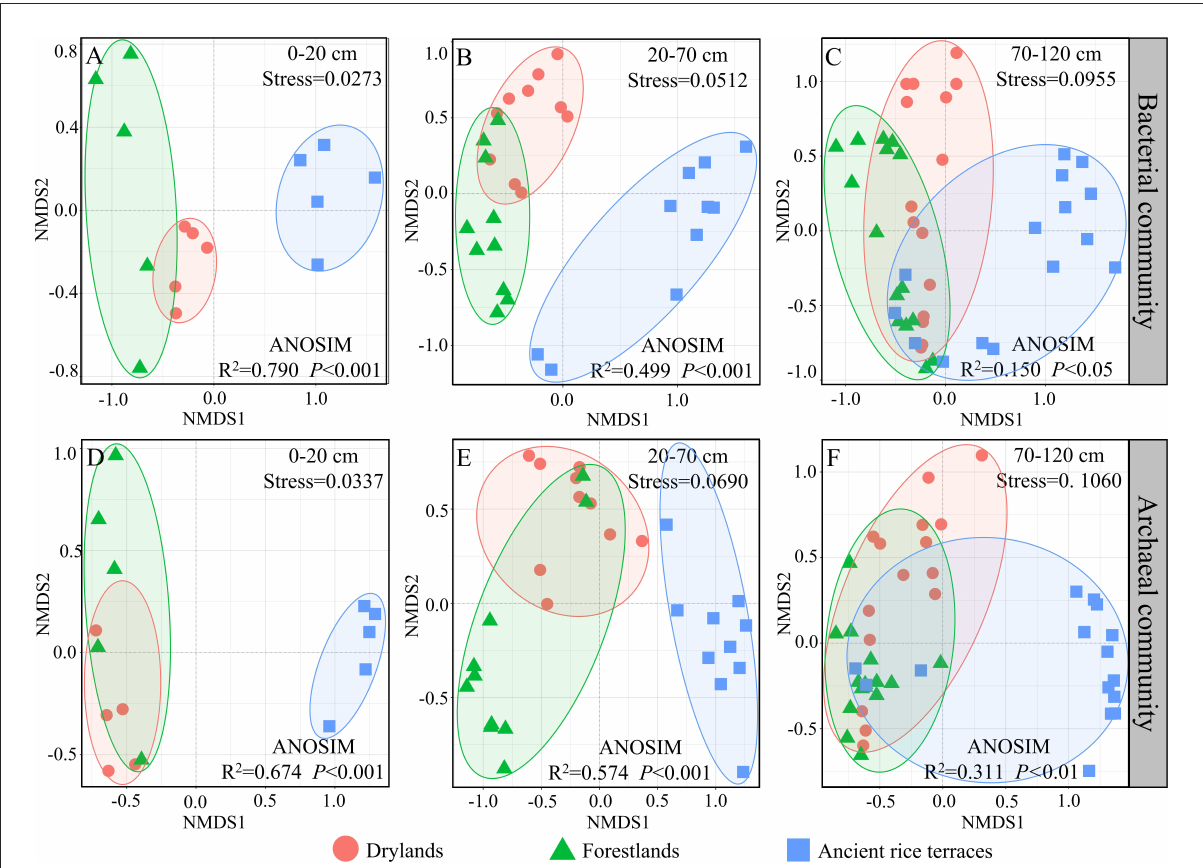
FIGURE4 (A–F) A nonmetric multidimensional scaling analysis of soil prokaryotic community composition of three land use types in different soil horizons based on Bray–Curtis dissimilarities. Analysis of similarity with the Bray–Curtis distance to test whether sample distributions are significantly